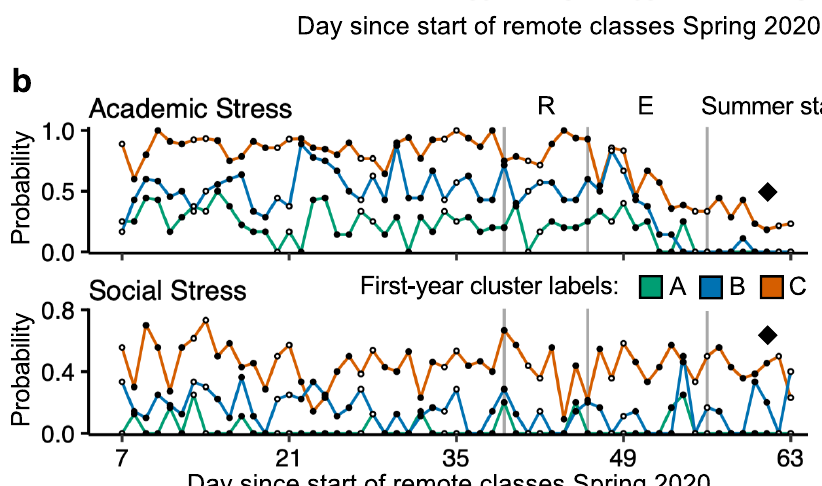
Figure 7. Student profiles prospectively predict experiences during the COVID-19 pandemic. ( a ) Boxplots on the left represent participant-means throughout the follow-up study period, grouped by the cluster labels assigned in the first-year study. Asterisks represent statistically significant differences between cluster pairs (two-tailed t -tests; *p < 0.05, **p < 0.01, ***p < 0.001). Time series on the right show cluster averages per each biweekly questionnaire timepoint. Error bars represent standard error of the mean. ( b ) Time series show daily observations averaged by first-year cluster labels. Diamonds emphasize the different trajectories of Academic versus Social Stress for Cluster C into Summer Break. R reading period, E exams